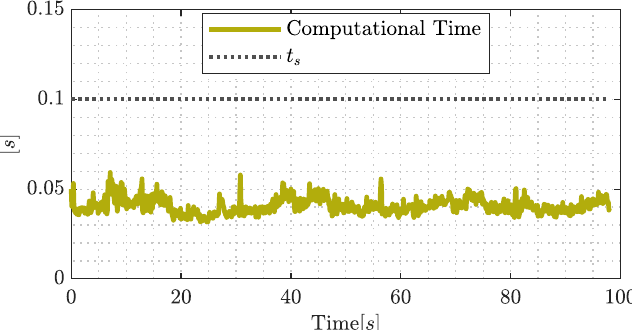
Figure 14. Computational time during the real-world experimental